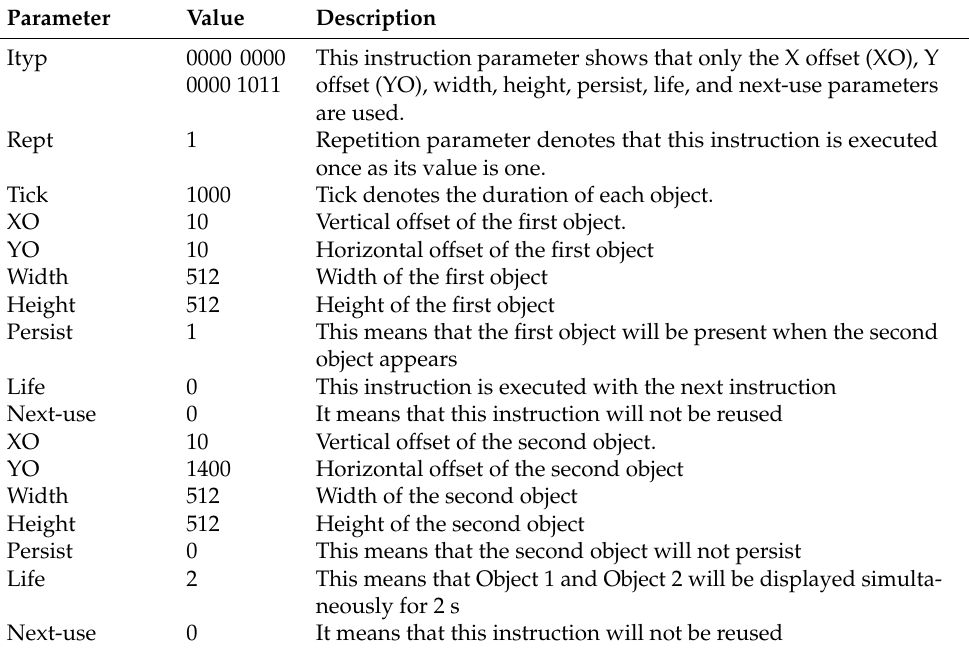
Table A2. Values of the INST parameters for the first example.